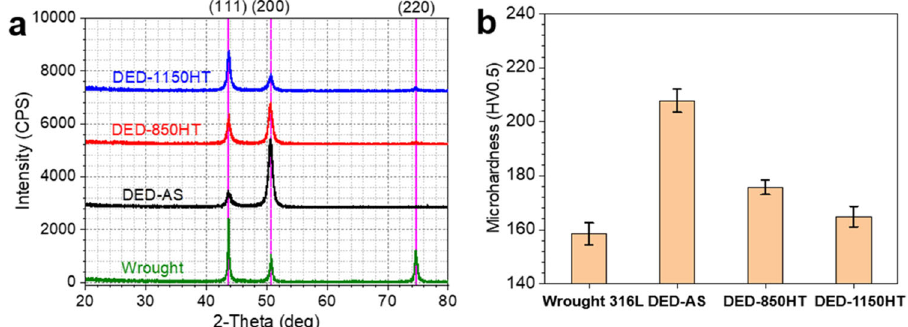
Fig. 2 XRD and microhardness results. a XRD spectra and b microhardness values of the as-manufacture and heat-treated DED 316L SS. The results of wrought 316L are also shown. Error bars in b show the standard deviations of more than six measured microhardness